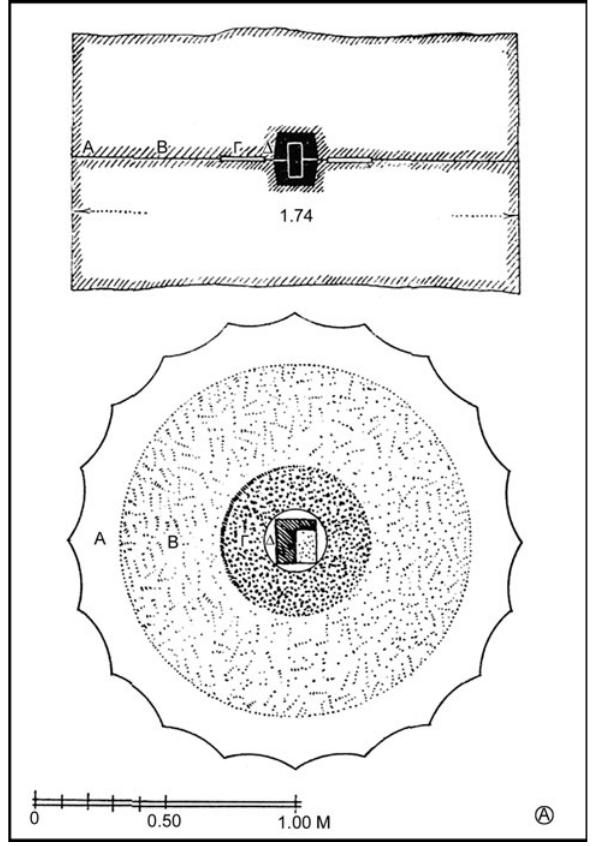
Figure 3 Schematic confi guration of a Parthenon column drum base in plan and section.